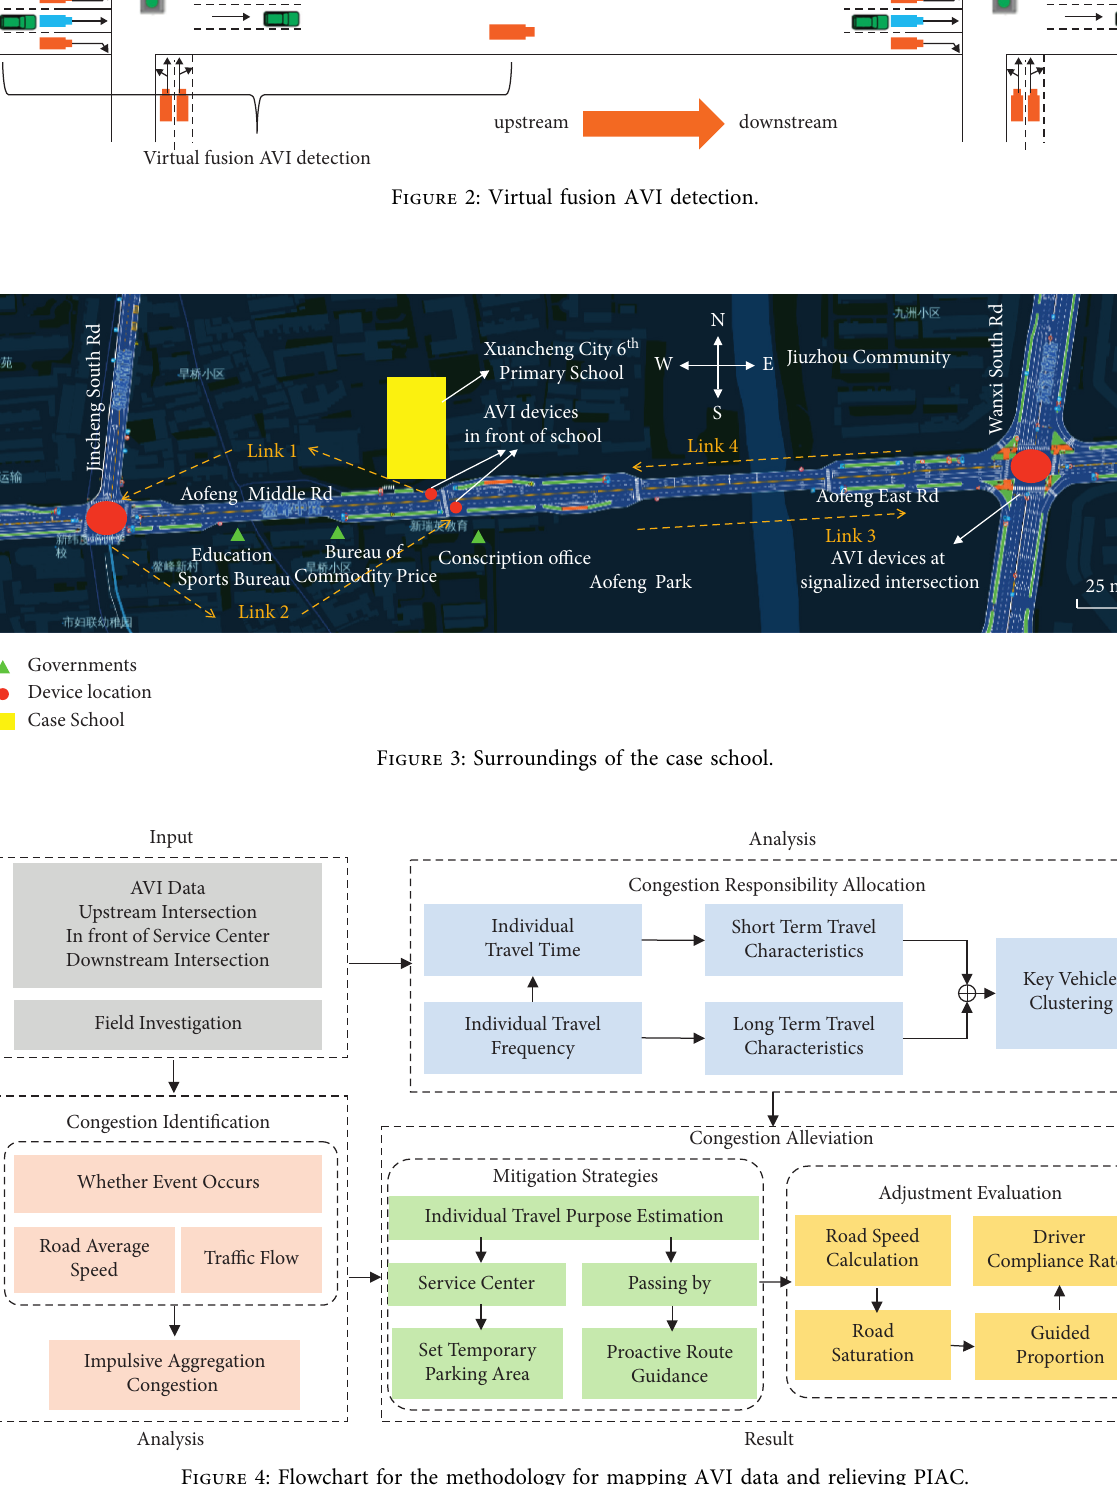
Figure 4: Flowchart for the methodology for mapping AVI data and relieving